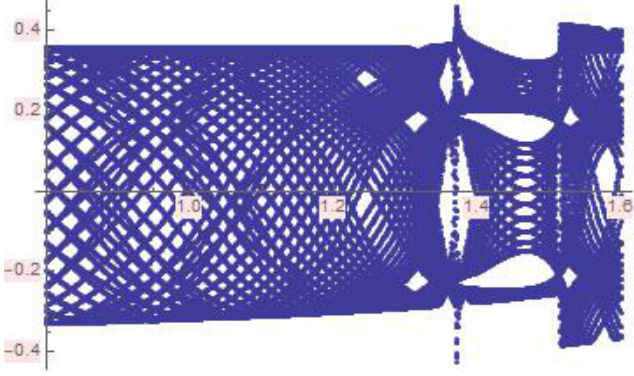
Figure 1. B.D. in ( β − x ) —plane, β between 0.8 and 1.6, α = 0.5 and the initial conditions ( 0.2,0.35 )